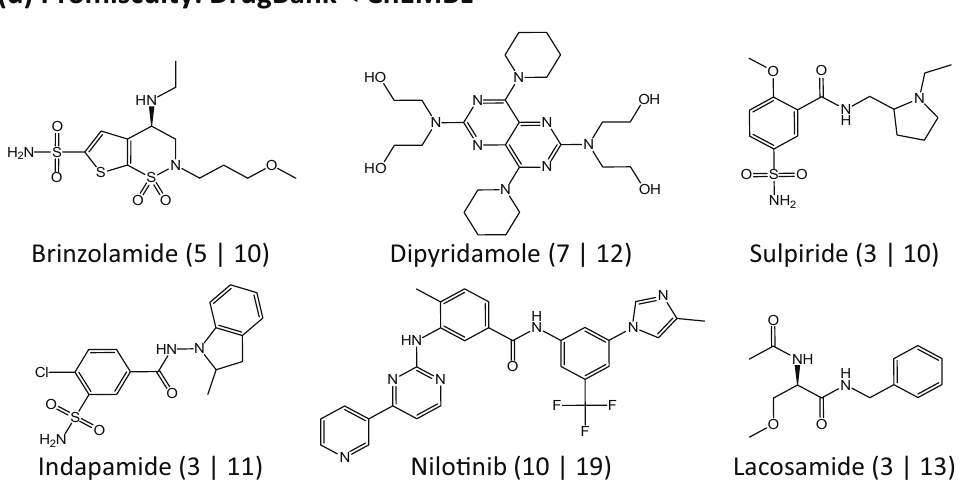
Figure 2. Drug promiscuity in DrugBank vs ChEMBL. ( a ) For 518 qualifying drugs, the number of targets reported in DrugBank and the number of high-confidence activity annotations in ChEMBL are compared in a scatter plot. Each dot represents a drug. The diagonal (indicating perfect correlation) is drawn in red. In ( b ), ( c ), and ( d ), exemplary drugs are shown that had the same number of targets in DrugBank and ChEMBL (i.e., the same promiscuity rate), a higher promiscuity rate in DrugBank, and a higher rate in ChEMBL, respectively. For each drug in ( b ), the number of targets is given. For each drug in ( c ) and ( d ), the numbers of targets reported in DrugBank and ChEMBL are compared. For example, “10 | 6” indicates that the drug was annotated with 10 targets in DrugBank and with six in the two databases. Only 32 drugs (~6%) were found to have the DrugBank were much higher than in ChEMBL. Exemplary drugs same number of target annotations in DrugBank and ChEMBL. having the same or different degrees of promiscuity in DrugBank and ChEMBL are shown in Figure 2b–Figure 2d. Differences in promiscuity rates were quantified, as reported in Figure 3a. Among the 486 drugs (~94%) with varying degrees of promiscuity in DrugBank and ChEMBL, 48 and 58 drugs differed by one and two targets, respectively. By contrast, the promiscuity